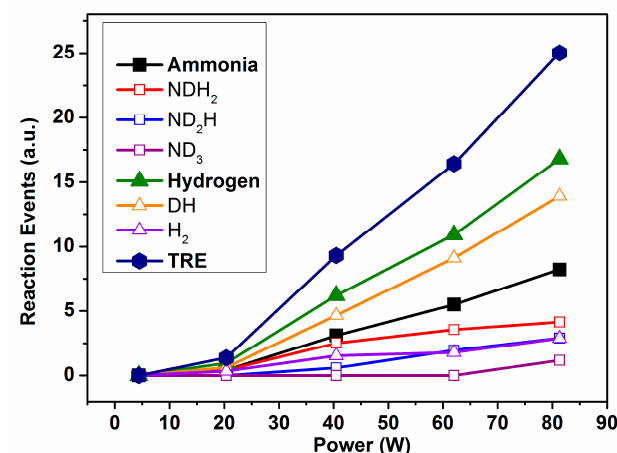
Figure 3. Evolution of reaction events (REs) and total number of exchange reaction events (TRE) for Reaction (1) as a function of plasma power.